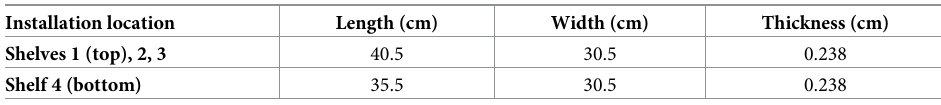
Table 3. Glass sheet